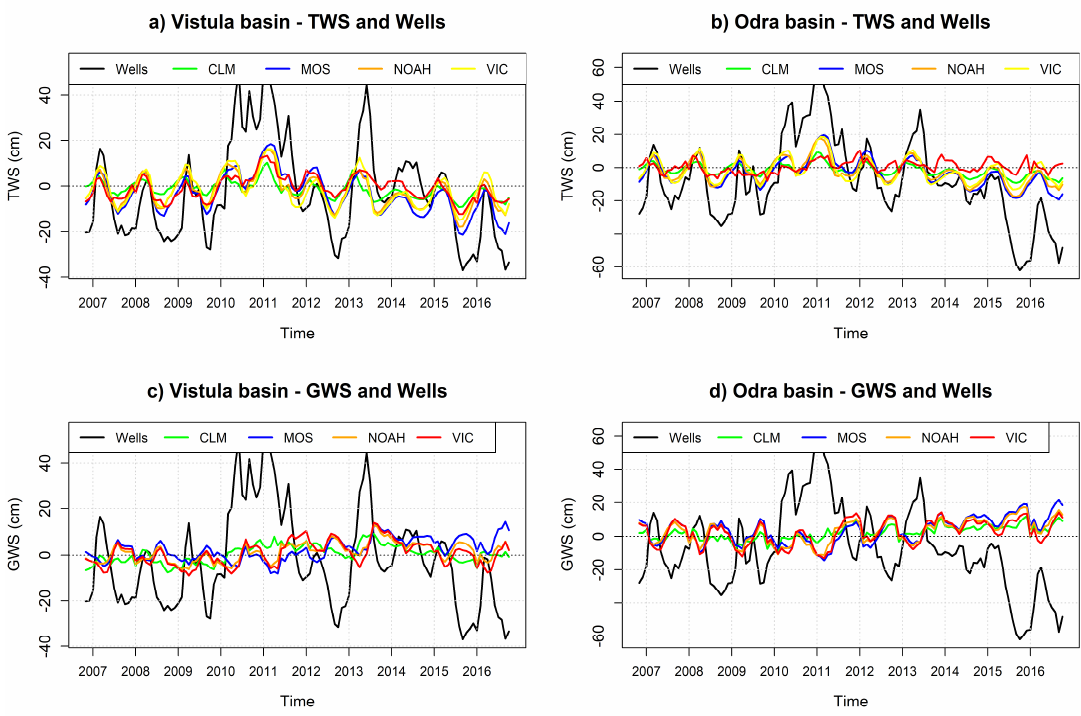
Figure 8. Well data compared to GRACE and GLDAS TWS ( a , b ) and to GWS ( c , d ).